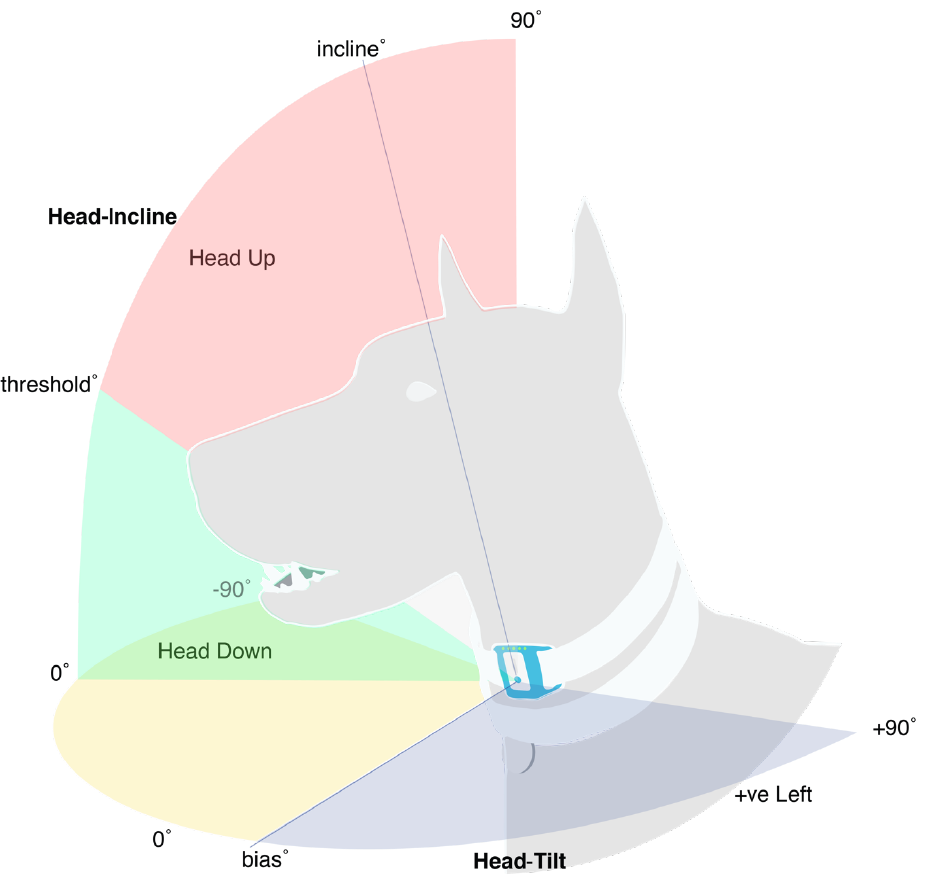
Figure 2. Pitch and Roll angles of the sensor map to head-tilt and head incline, respectively. The angle of 14° was found to be the optimised threshold to classify head-down posture while recumbent.